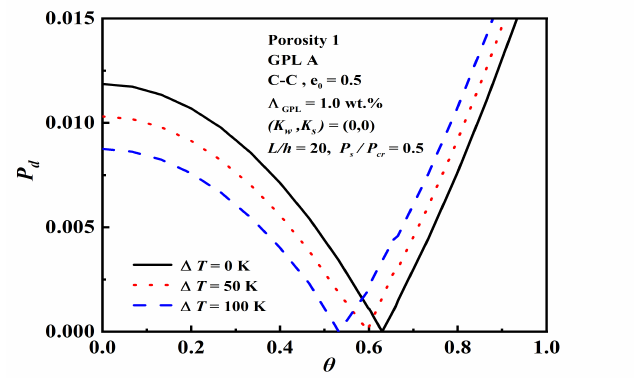
Figure 15. Effect of initial thermal loading ∆ T on dynamic